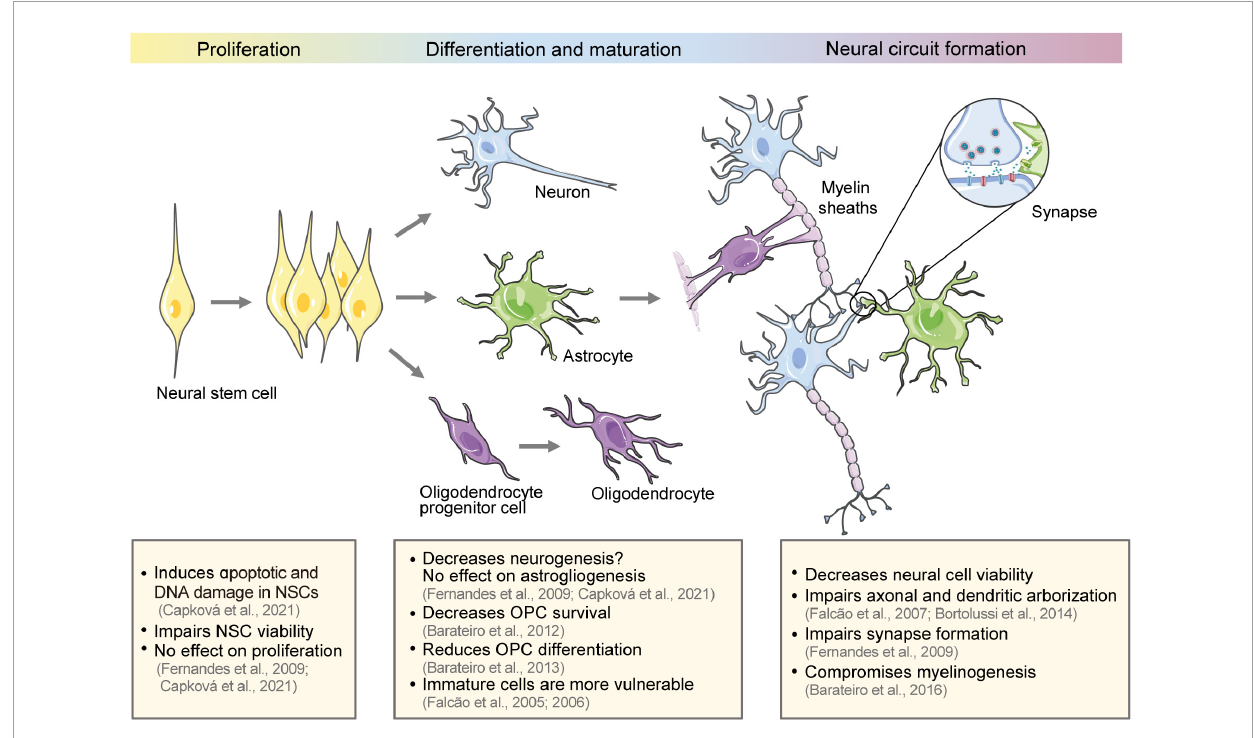
FIGURE1 Effect of bilirubin on the development of neural circuits. The schematic diagram shows the development of neural circuits and the effect of bilirubin on different development stages, including NSC proliferation and differentiation, neural cell maturation, and neural circuit formation. NSCs, neural stem cells; OPCs, oligodendrocyte progenitor